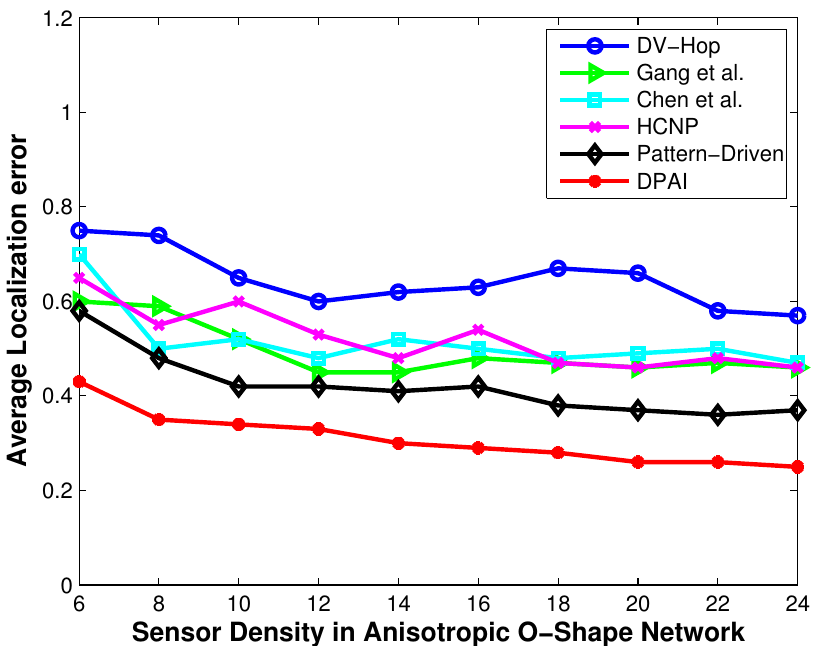
Figure 7. Localization error vs . sensor density (O-shape